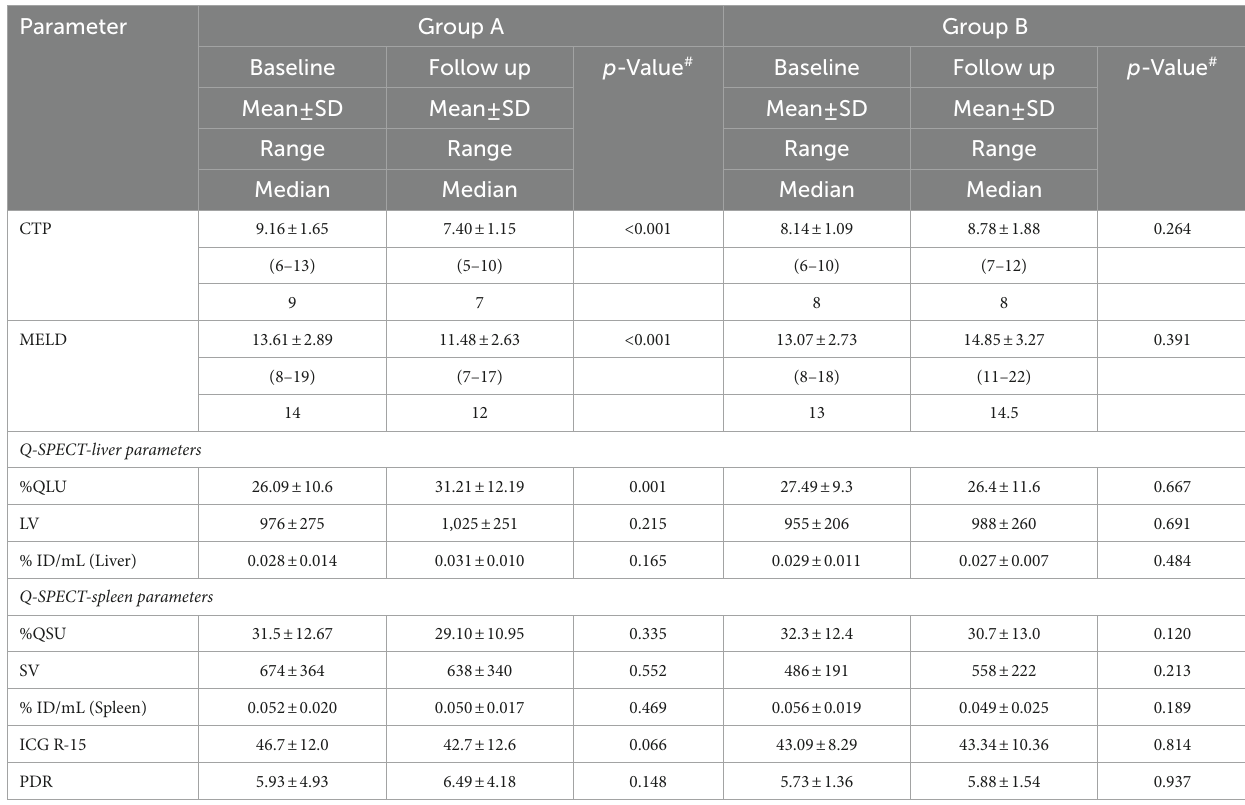
TABLE 3 Change in disease severity scores, Q-SPECT/CT and ICG parameters in G-CSF treated (Group A) and Standard medical therapy groups (Group B).